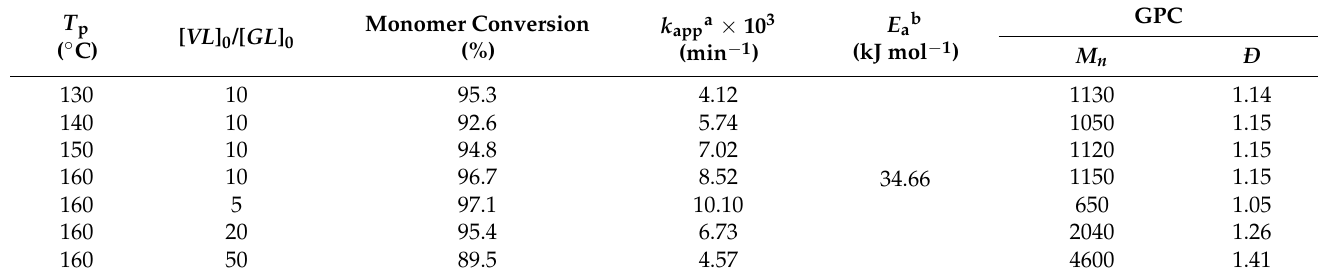
Table 6. Kinetic results for the ROP of VL under various conditions using DMC-NMe and GL ini- tiator.